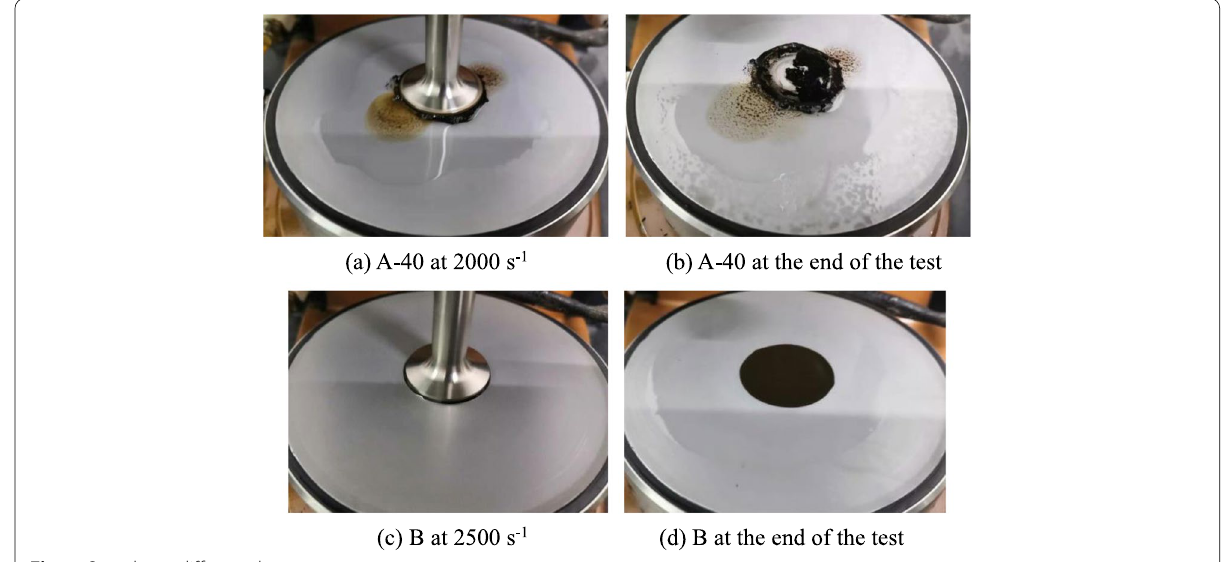
Fig. 5 Samples at different shear